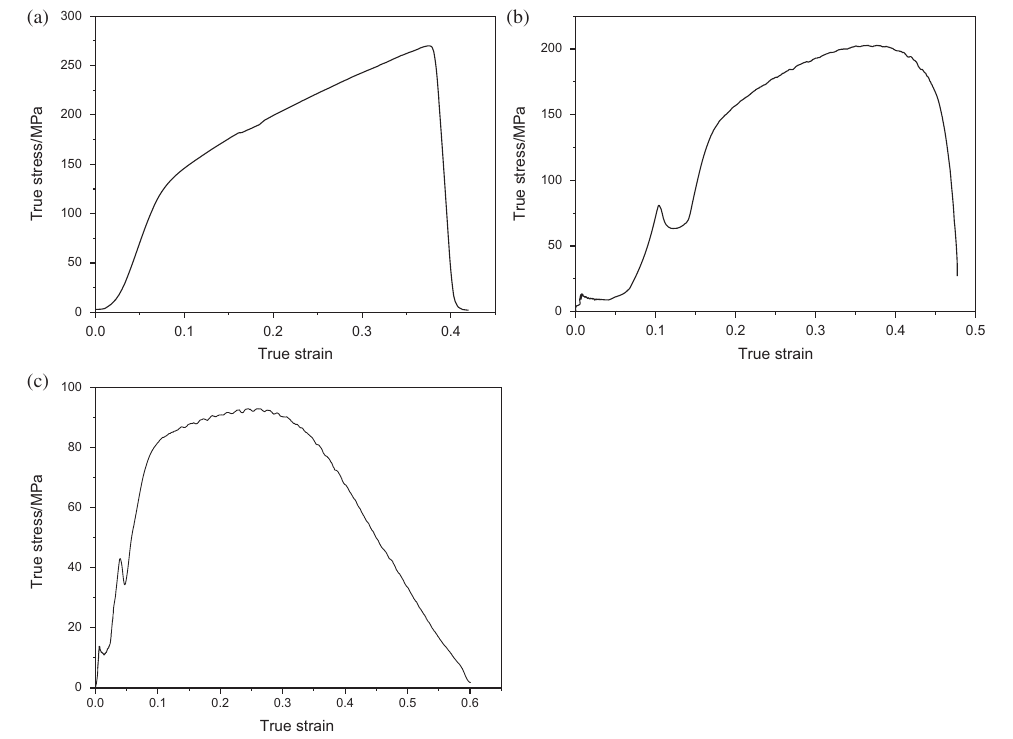
Figure 5: True stress – strain curves of the investigated steel at two temperatures of (a) 750°C, (b) 800°C and (c)